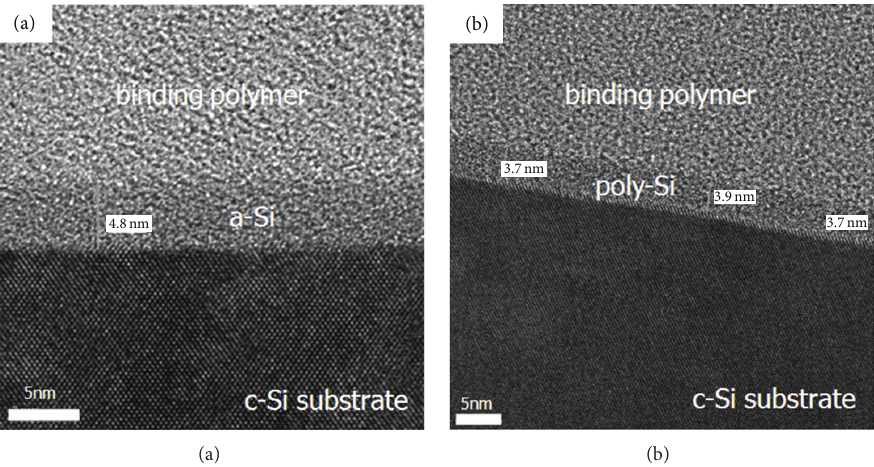
Figure 4: Cross-sectional TEM images of (a) the a-Si film deposited by PECVD and (b) the poly-Si film formed by crystallization of a-Si after going through a high-temperature diffusion process.